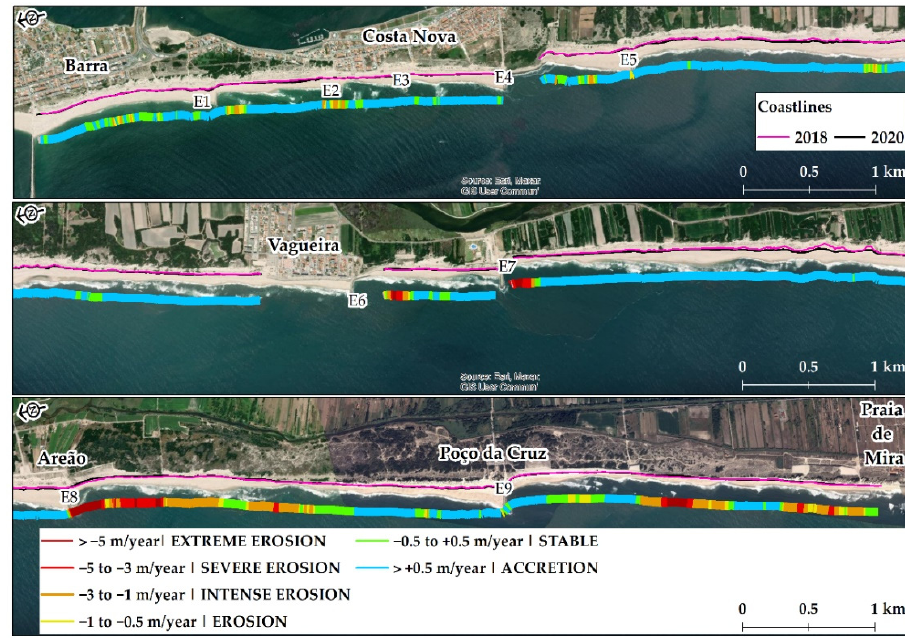
Figure 2. Coastline evolution from 2018 to 2020.